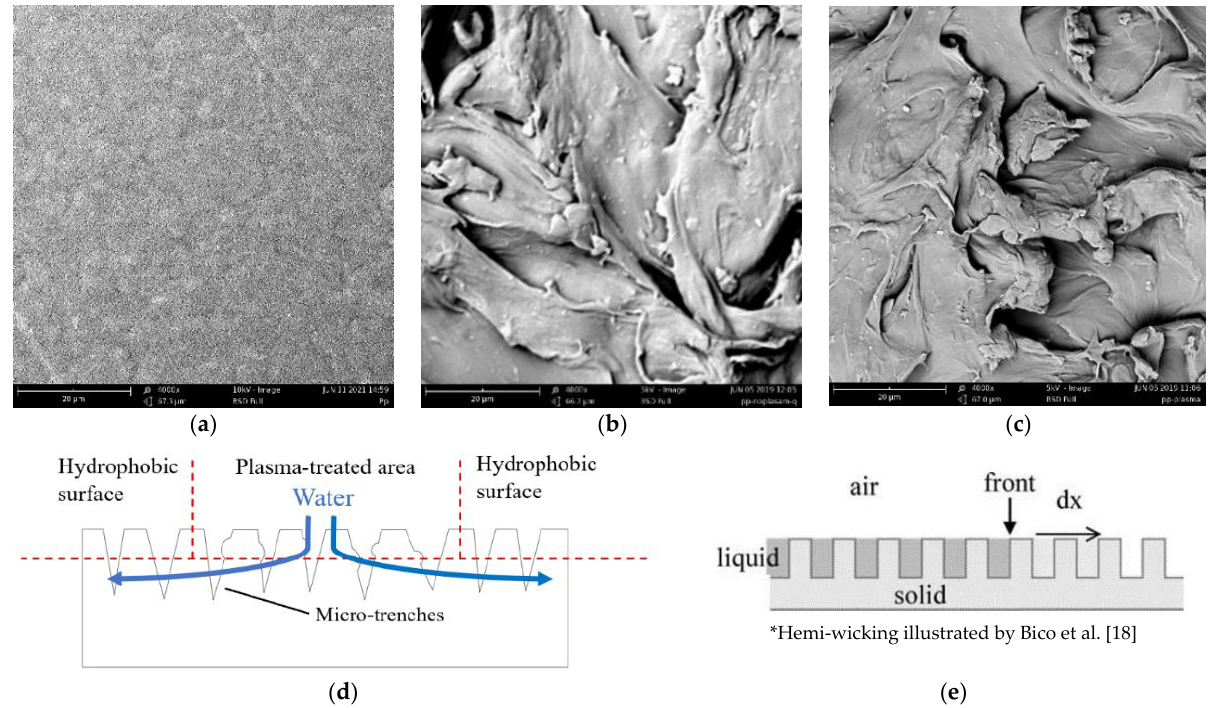
Figure 7. ( a ) SEM micrograph of untreated PP surface, ( b ) SEM micrograph of sanded PP surface, ( c ) SEM micrograph of PP surface treated by sanding and then plasma, ( d ) diagram of hemi-wicking phenomena on the sanded surface applied by the plasma activation, and ( e ) diagram of hemi-wicking phenomena illustrated in the prior study.